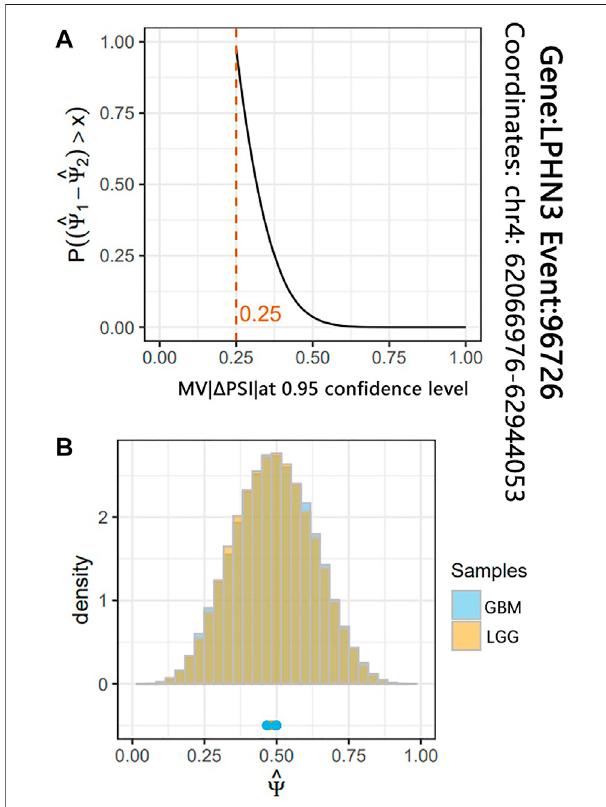
FIGURE 3 | The results of differential analysis for the AS event 96726 of LPHN3 gene. (A) The red line indicates that the maximum probability of Δ PSI of AS event 96726 between LGG and GBM subjects is greater than 0.25. (B) The histogram shows the two joint posterior distributions over PSI and the point estimates for each